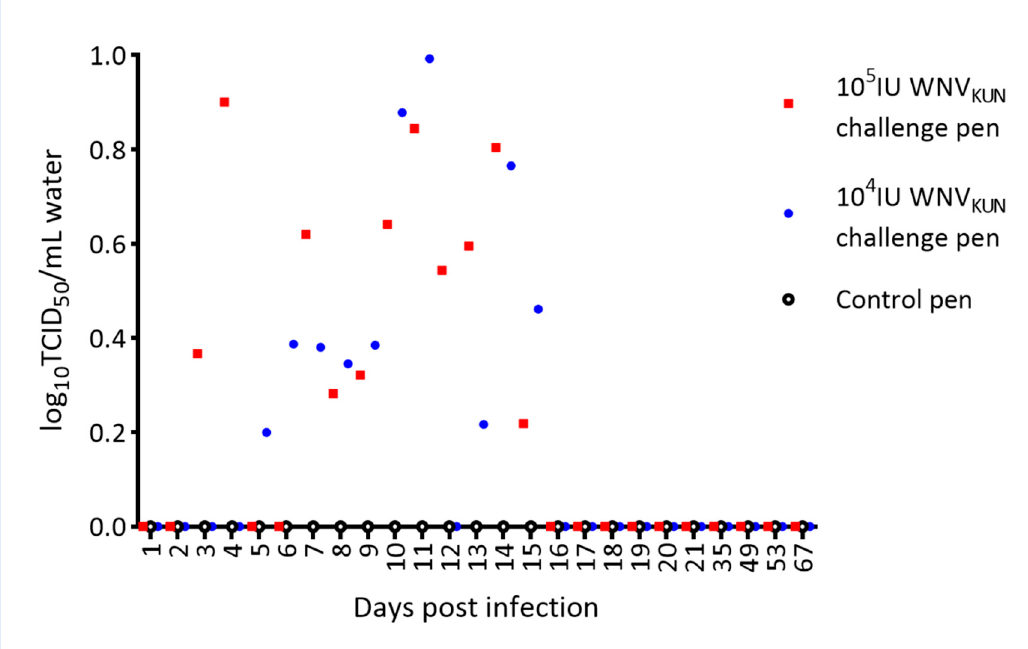
Figure 8. WNV KUN RNA detection in pen water by qRT-PCR. Data are shown as TCID 50 -equivalents. Pen water was collected daily just prior to cleaning of the pen and RNA isolated from filters following filtration of 60 mL of water.